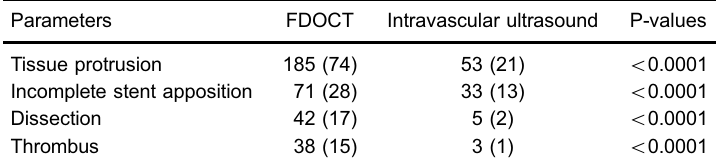
Table 3. Qualitative analyses of suboptimal lesion morphology.